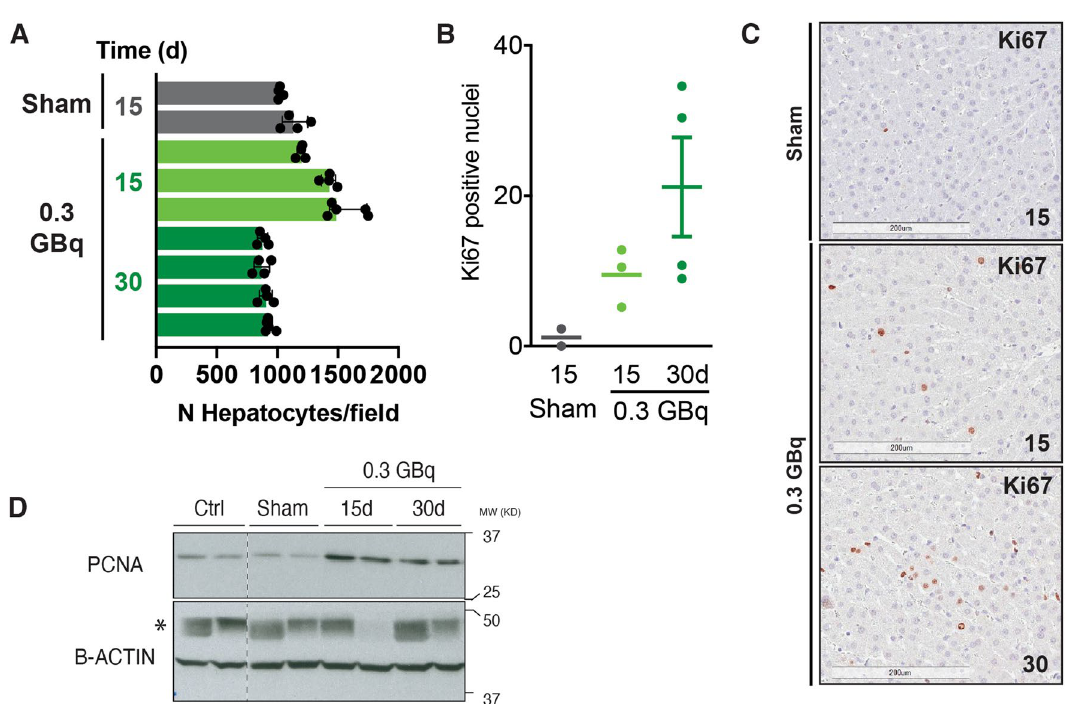
Figure 7. Liver hyperplasia in CL after CrLs SIRT with 0.3 GBq (200 Gy) at 15 and 30 days. ( A ) Quantitative hyperplasia in 0.3 GBq in comparison with sham group. ( B ) Quantification of Ki67-positive nuclei and ( C ) representative Ki67 stainings in CL in 0.3 GBq and sham group. ( D ) PCNA and B-Actin protein expression in 0.3 GBq, sham and control group. MW molecular weight, KD kilodaltons, *unspecific